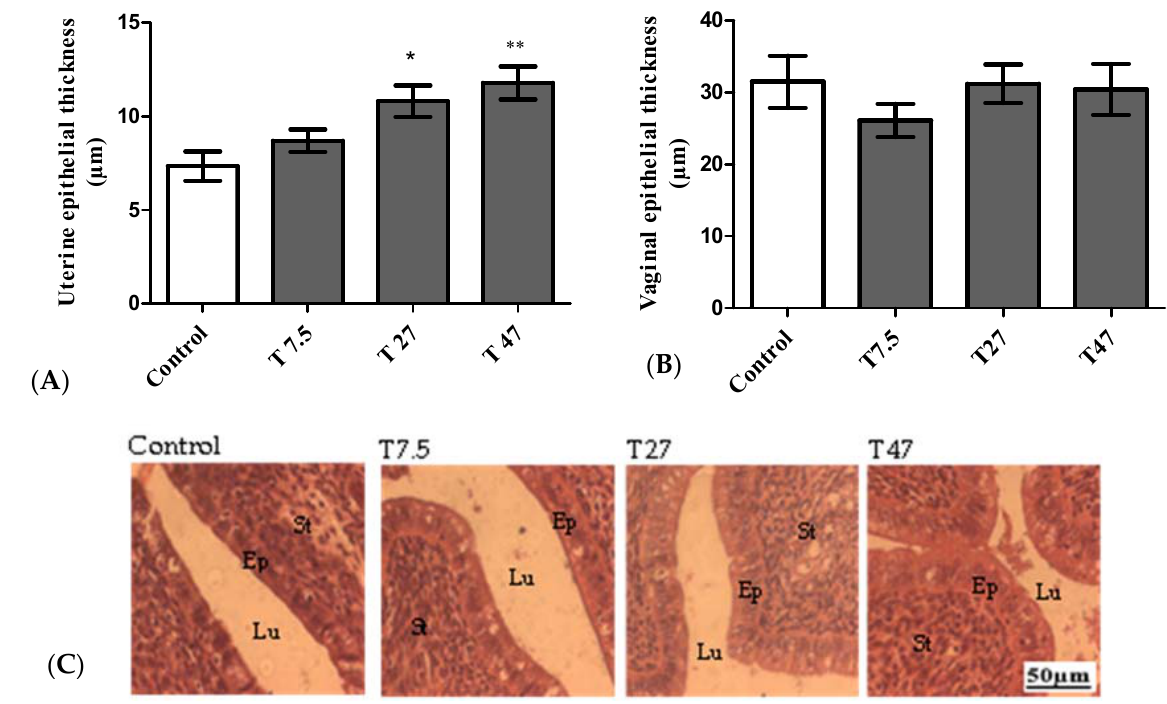
Figure 4. Effect of tartrazine on uterine ( A ) and vagina ( B ) epithelial height as well as microphoto ‐ graphs (25×) of hematoxylin/eosin ‐ stained sections of uteri ( C ) of immature female Wistar rats after 40 days of treatment. Control = animals receiving vehicle (distilled water, 10 mL/kg BW); T = rats treated with tartrazine at doses of 7.5; 27, and 47 mg/kg BW. Results are presented as mean ± SEM; n = 5. *: p < 0.05; **: p < 0.01 compared to the control. Lu = Lumen; Ep = Epithelial cell thickness; St = Stroma.